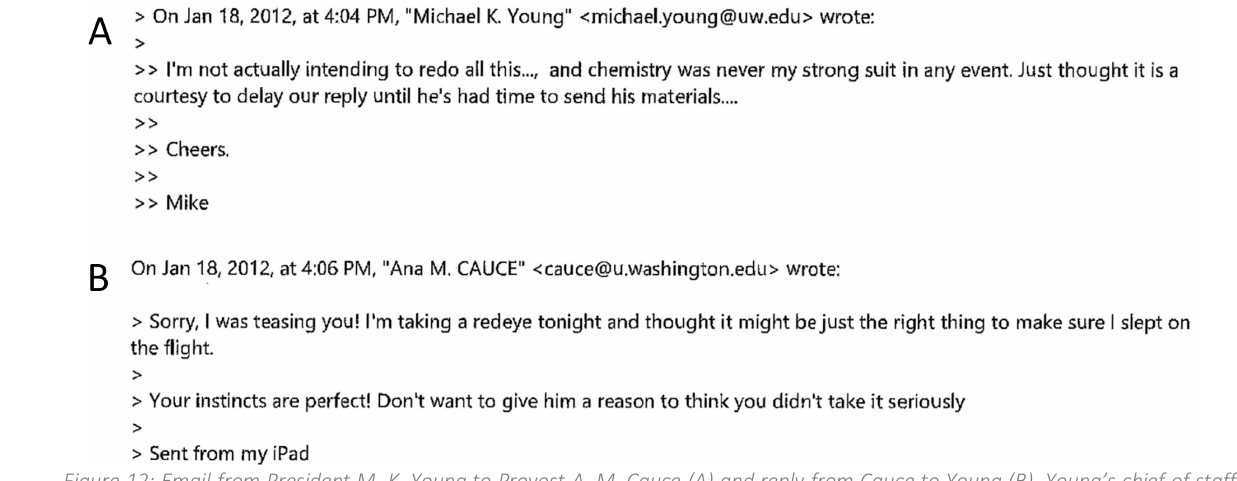
Figure 12: Email from President M. K. Young to Provost A. M. Cauce (A) and reply from Cauce to Young (B). Young’s chief of staff, Jack Johnson, replied to BK on the president’s behalf, “This office has reviewed the correspondence on this matter and conferred with those who conducted the earlier examinations of your allegations.”(Johnson JG. Letter to Kahr B. 2012 January 26, see